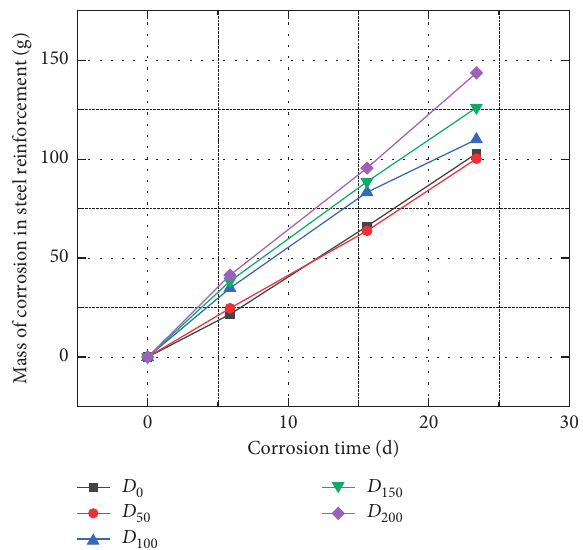
Figure 4: The mass change of steel reinforcement after varied corrosion